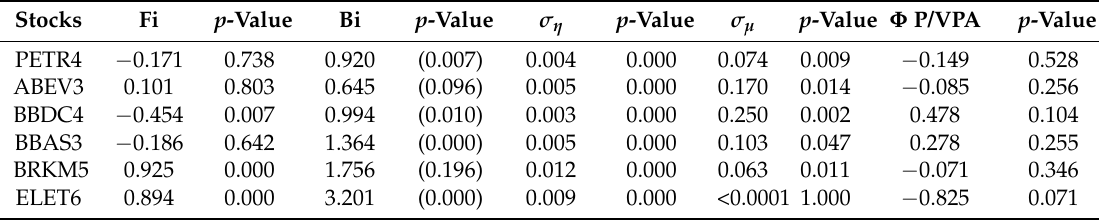
Table A6. Coefficients of the model with all